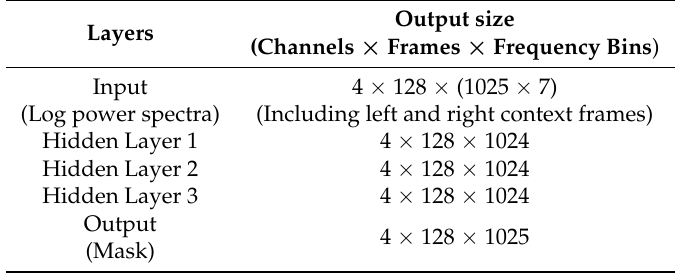
Table 1. Configuration of DNNs for dereverberation and the beamformer.